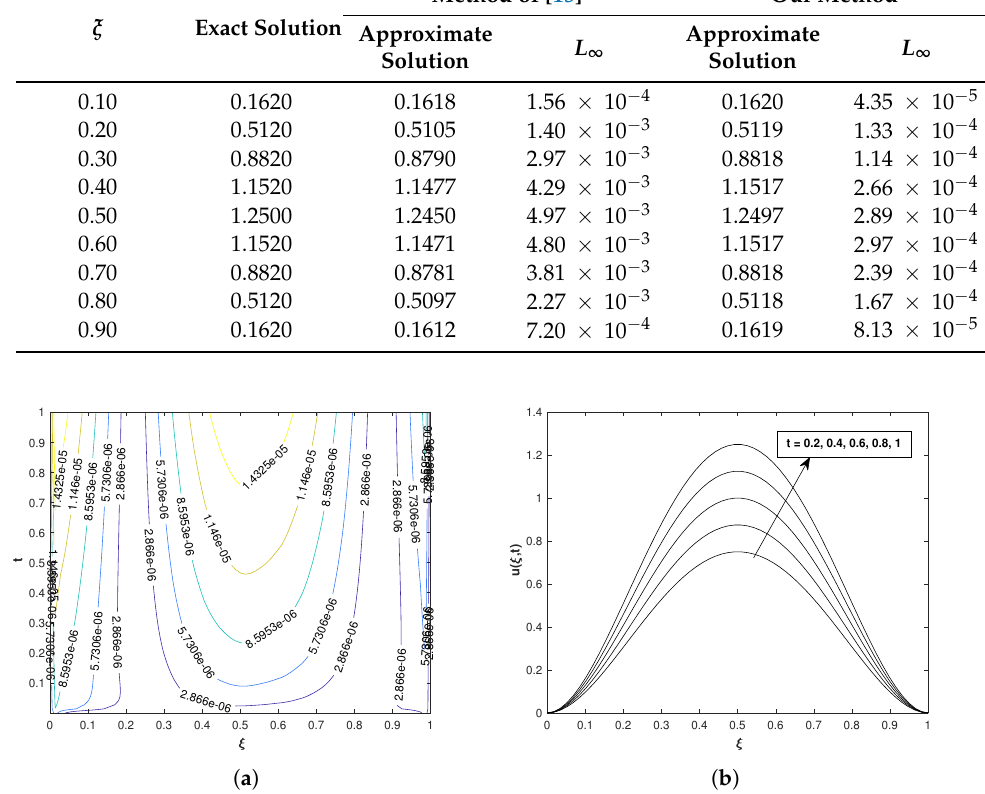
Figure 5. ( a ) Contour plot of the absolute error of Problem 2 with α = 0.8, N = 75, n = 15, and M = 26. ( b ) Solution behavior of Problem 2 at different values of t with N = 60, α = 0.7, n = 12, M = 28. It is observed that the solute concentration increases with